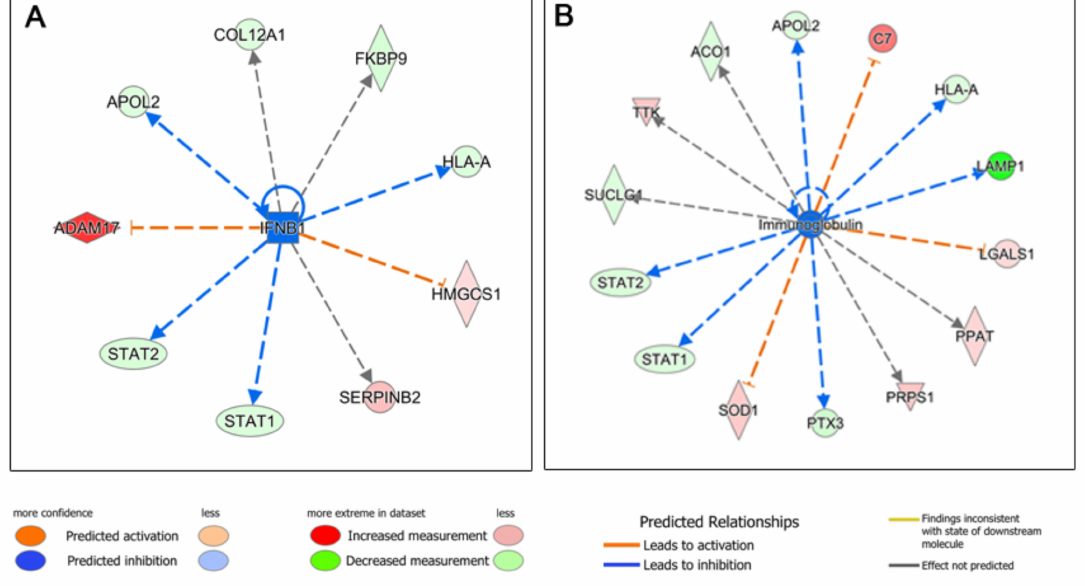
Figure 6. Ingenuity Pathway Analysis (IPA) of proteins deregulated in human dermal fibroblasts (HDFs) treated with leukocyte- and platelet-rich plasma (L-PRP) supernatant and related to an inflammatory response. Deregulation related to stimuli similar to those provided by ( A ) IFNB1 or ( B ) immunoglobulins was